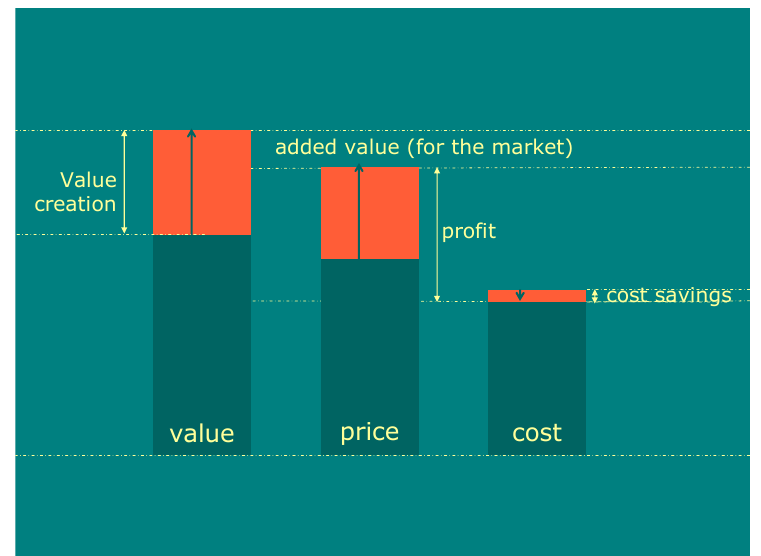
Figure 1: improving margins by creating value in the supply chain provide better opportunities than cost